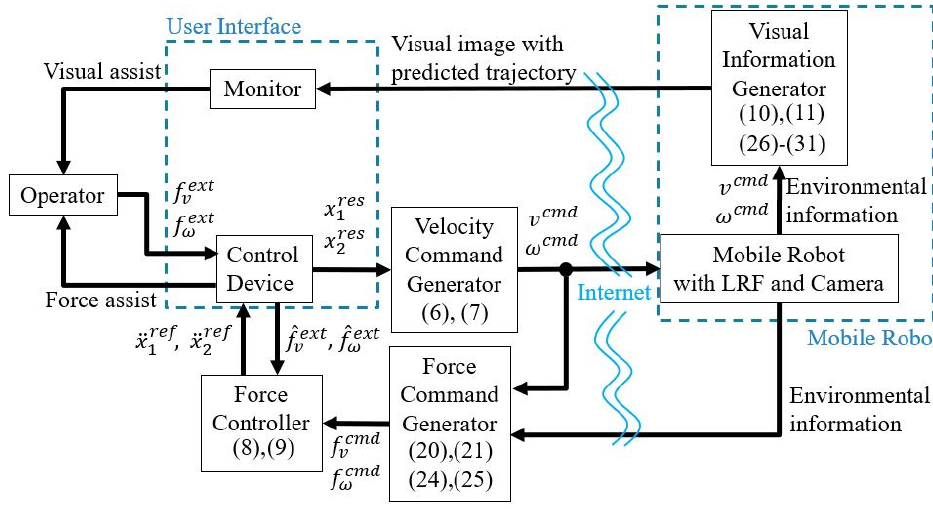
Figure 5. System